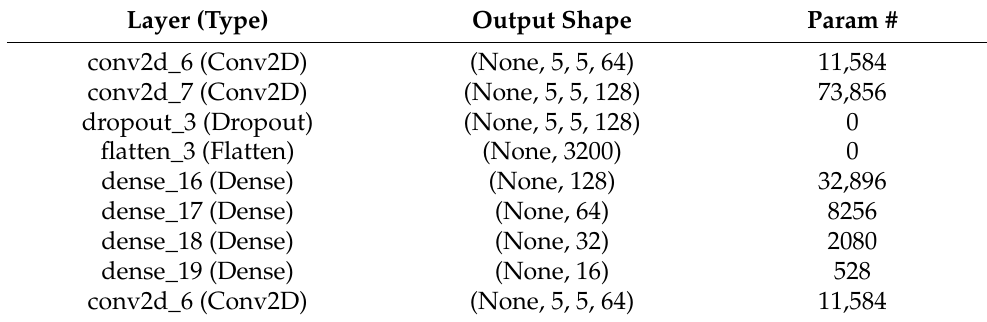
Table 5. CNN Model used for Salinas